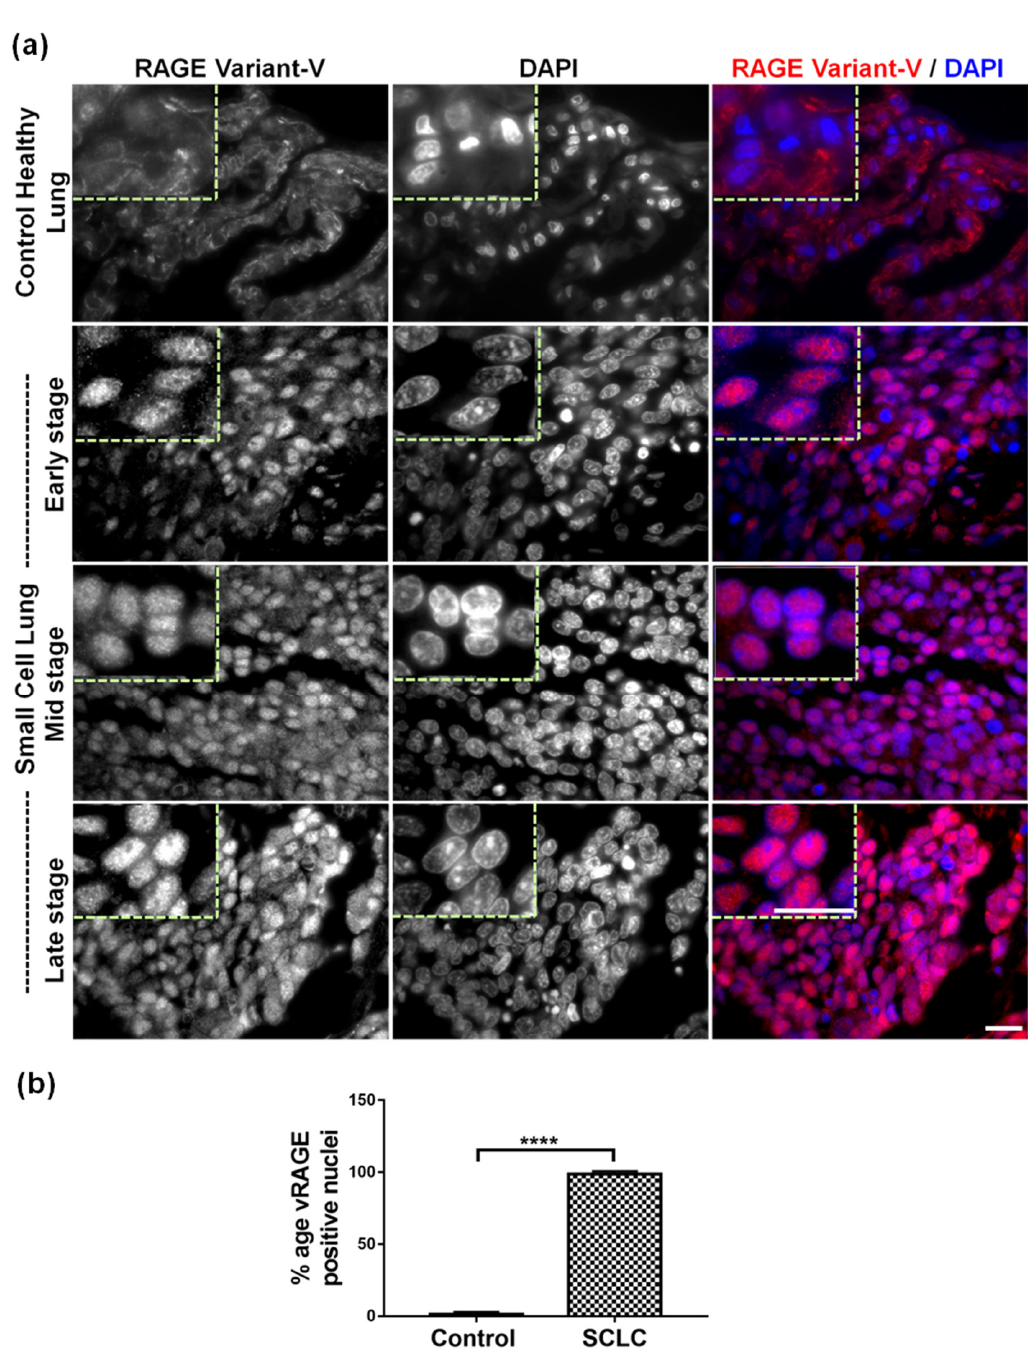
Figure 4. Expression of vRAGE in metastasizing human SCLC samples. ( a ) The representative immunofluorescence images of human lungs diagnosed at different stages of small cell lung carcinoma progression or the healthy control lungs. Staining was performed using a vRAGE specific antibody. The red-stained areas represent the vRAGE specific signal. The DAPI (in blue) represents the nucleus (Scale 10 µ m). Anthropometric details of these patients are given in Table 1. ( b ) The quantitative analysis showing the percentage nuclear positivity of the indicated sections for vRAGE antibody. (n SCLC = 80 and n Control = 20, Data presented as mean ± SD, ****: p ≤ 0.0001).